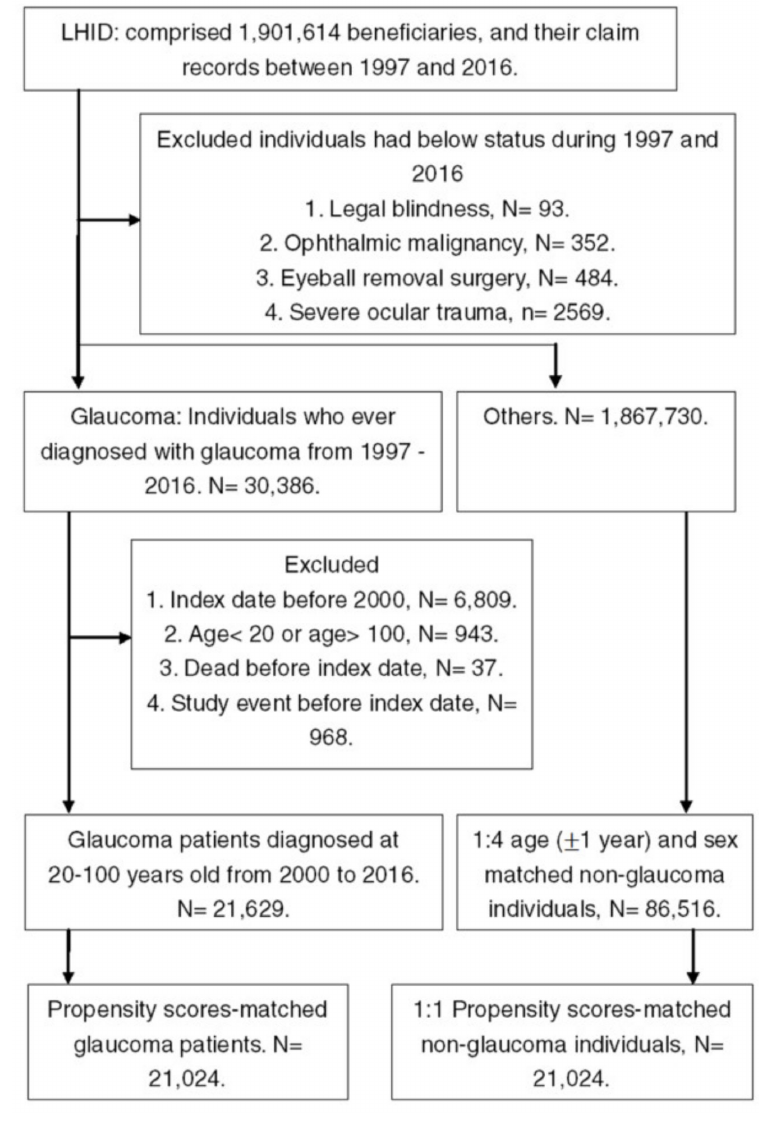
Figure 1. The flowchart of subject selection. LHID: Longitudinal Health Insurance Database 2005 version; N: